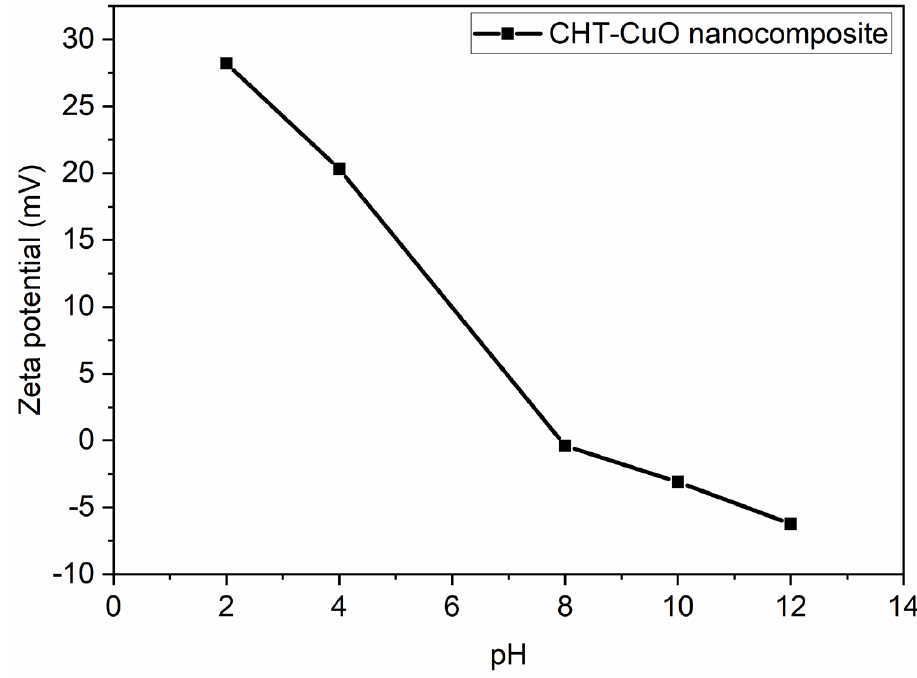
Figure 4. Zeta potential plot for CHT − CuO nanocomposite at different pH values.